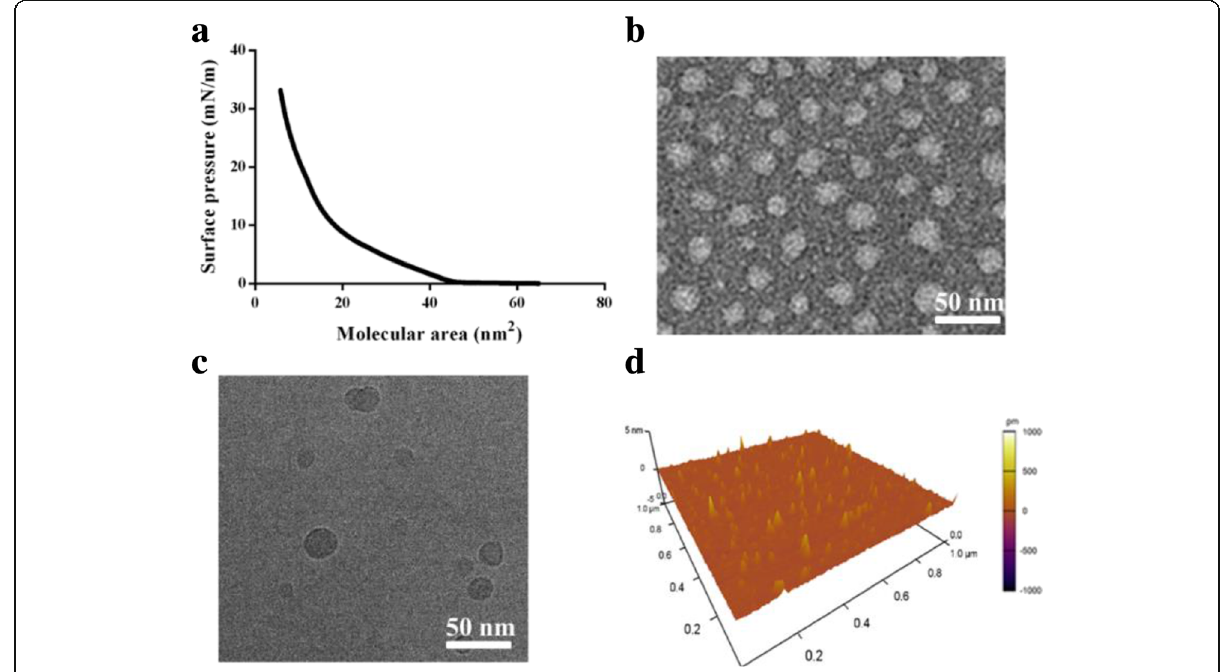
Fig. 2 Characterization of blank RUB nanoparticles. a The surface pressure-molecular area isotherms of RUB nanoparticles. b Transmission electron microscopy (TEM) image of RUB nanoparticles. c The corresponding cryogenic transmission electron microscopy (Cryo-TEM) image of RUB nanoparticles. d Atomic-force microscopy (AFM) image of RUB